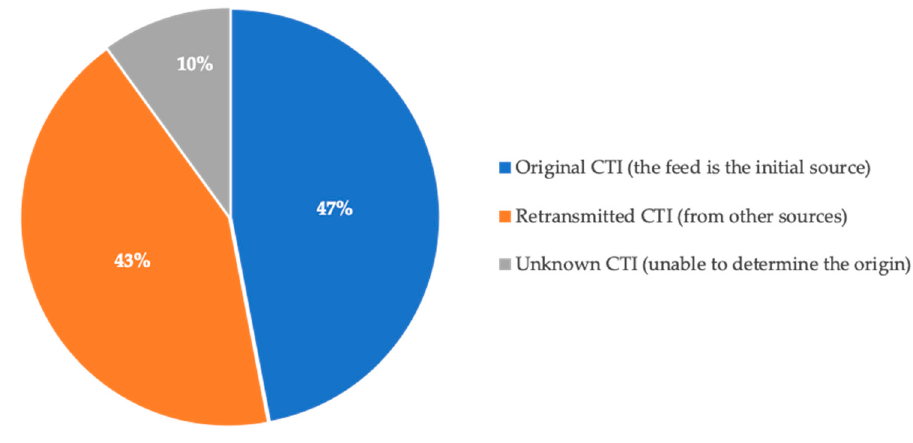
Figure 1. CTI source originality .